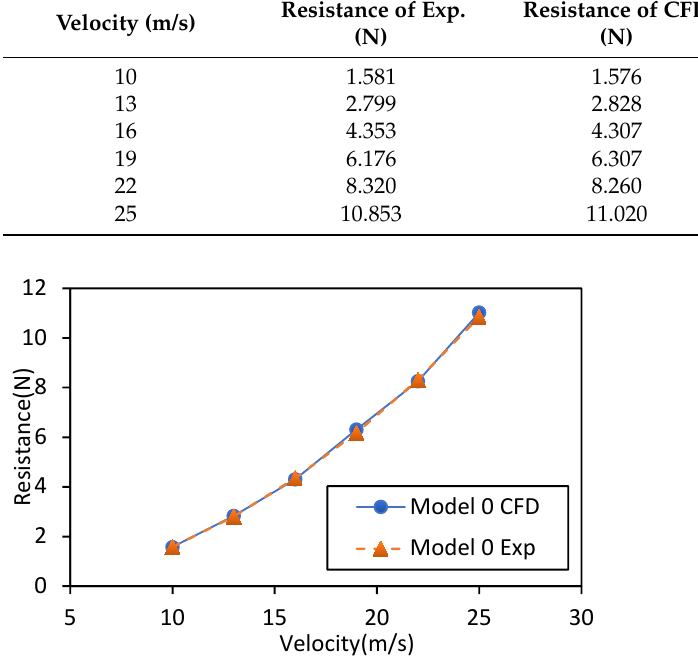
Figure 8. Comparison of experimental data and simulation data.